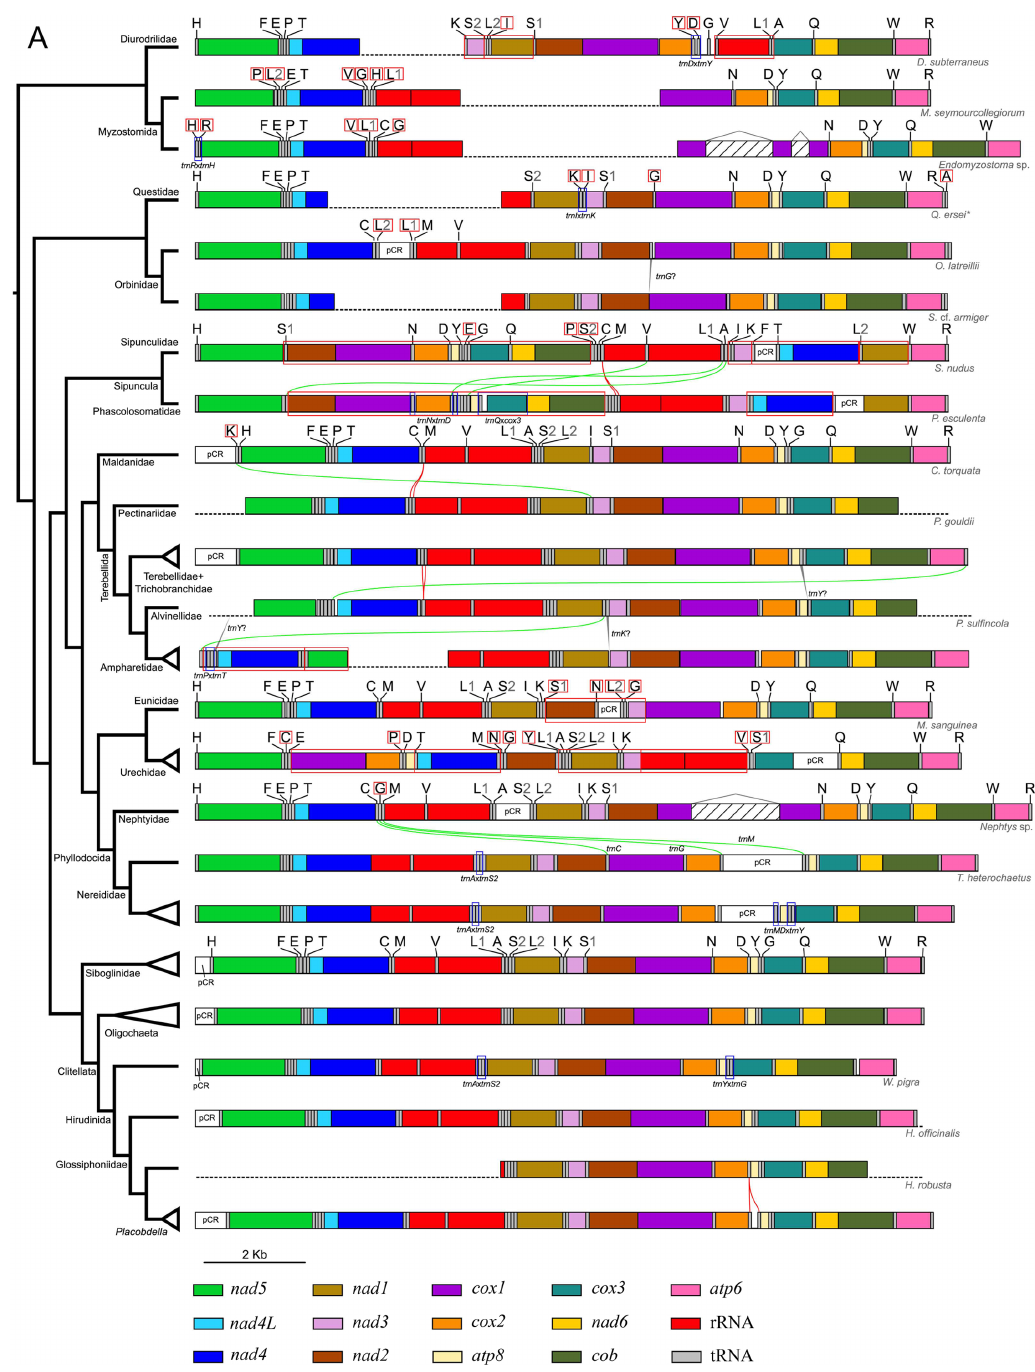
Fig 1. Gene order from available mitochondrial genomes of Annelida. The phylogeny on the left was inferred by Bayesian methodology. Colors indicate each of the 13 different protein-coding genes present in the mitochondrial genomes. Genes are scaled to real length. Green lines connecting one horizontal bar to another track the position of tRNA gene rearrangements. Red lines are used to indicate duplication of tRNA genes. Red boxes around tRNA gene- names indicate putative rearrangements of tRNA genes relative to the mutual gene order for Clitellata. Red boxes around blocks of genes highlight syntenic regions, which may have been rearranged as a single unit. Blue boxes around blocks of genes denote inversions and, finally, incomplete or missing data are denoted by dashed lines. Names of RNA genes are denoted only when there has been a change in sequence, if RNA genes are not denoted, their sequence is equal to the closest sequence above for which genes are denoted. In some cases, however,